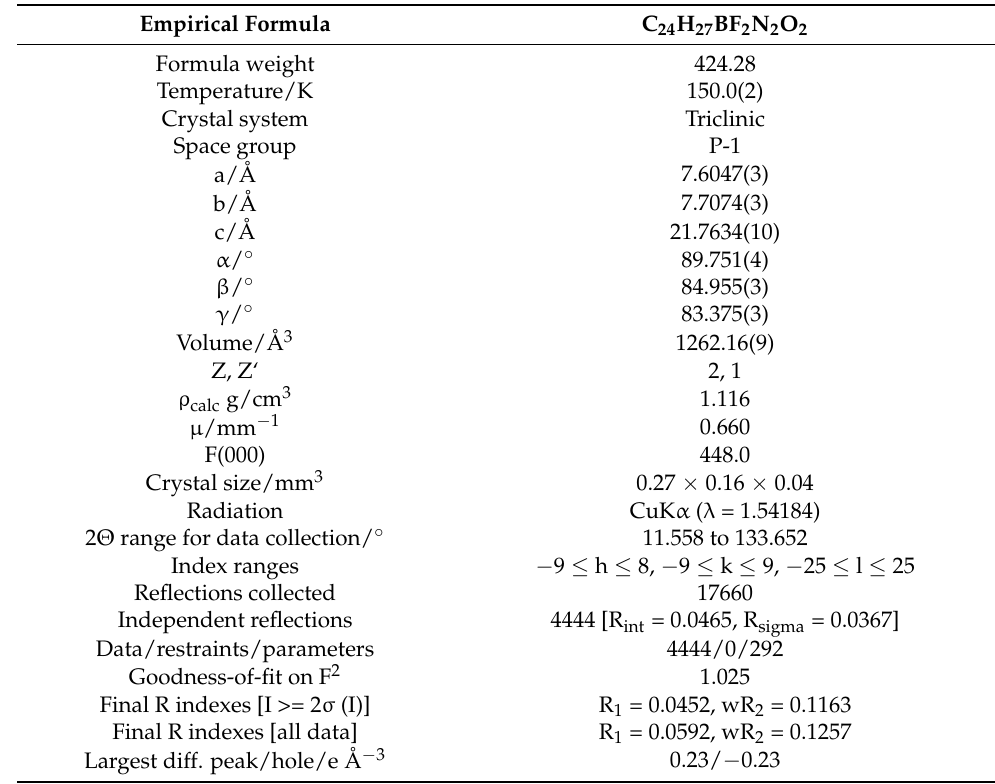
Table 1. [N ∩ NBF 2 ] crystal refinement